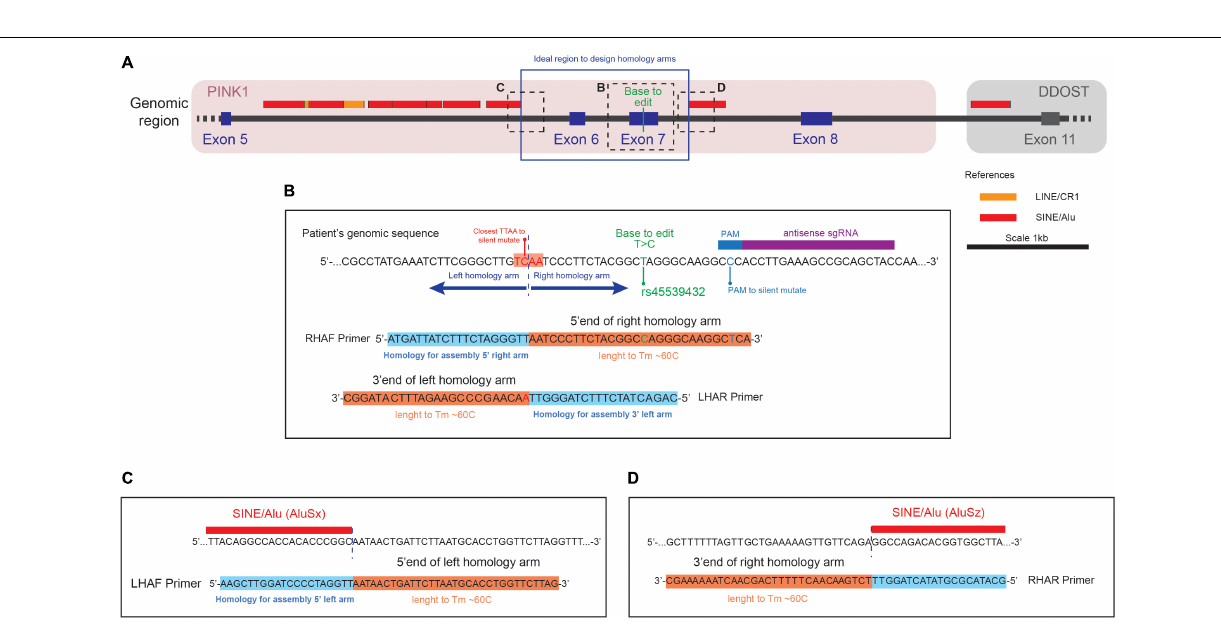
Frontiers in Genetics |